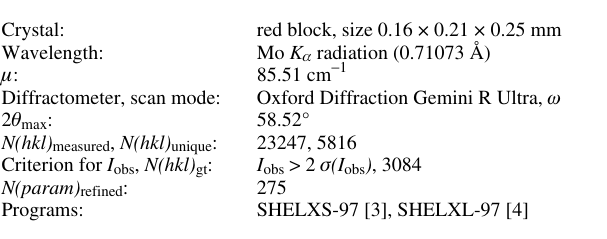
Table 1. Data collection and handling.